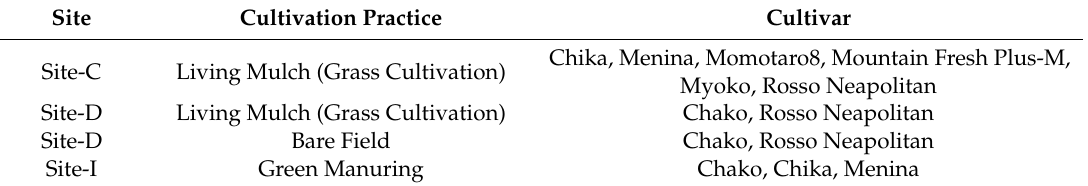
Table 1. Natural farming tomato ( Solanum lycopersicum ) cultivars used for the isolation of stem endophytes. These sites belong to International Nature Farming Center (INFC); 5632-1 Hata, Matsumoto, Nagano,